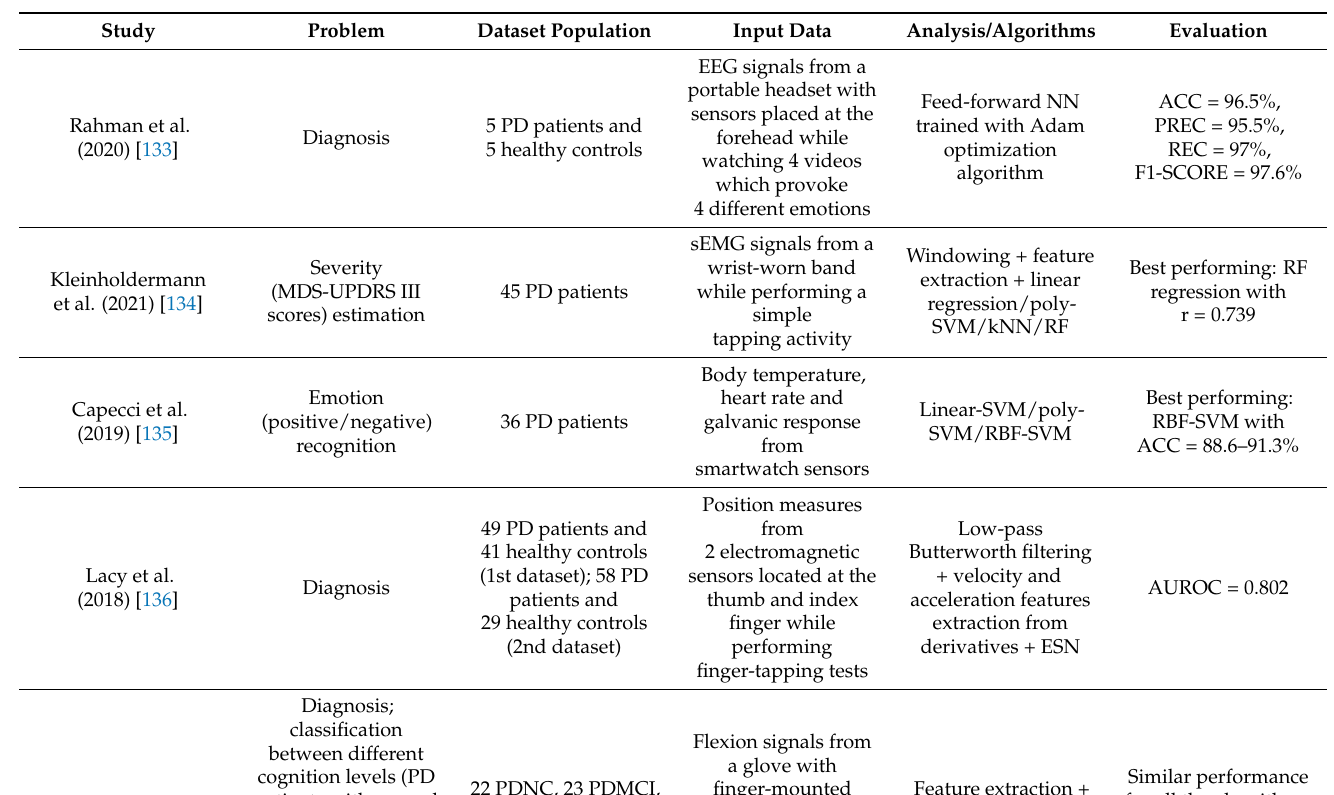
Table A5. Studies based on other types of